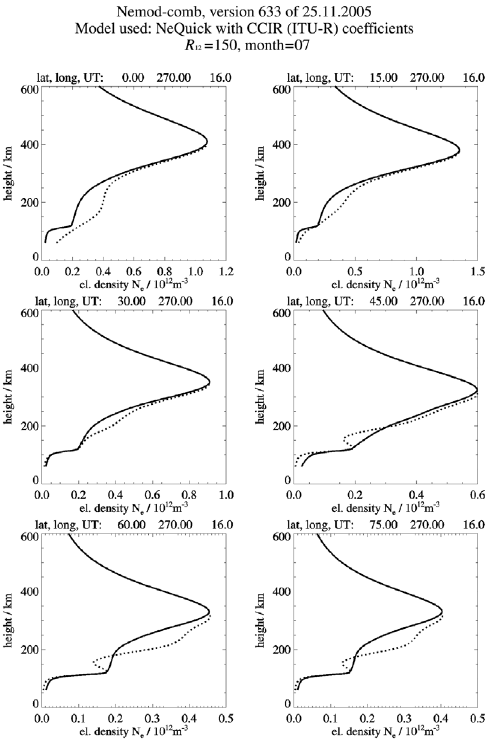
Fig. 5. Height profiles of electron density: July; R 12 = 150; 16 h UT; geografic longitude 270°E; 10 h LT; geografic latitudes 0°N ( top left ) to 75°N ( bot- tom right ); latitude spacing 15°. Solid curves: re- vised NeQuick, dotted curves: NeQuick, old formu- lation.